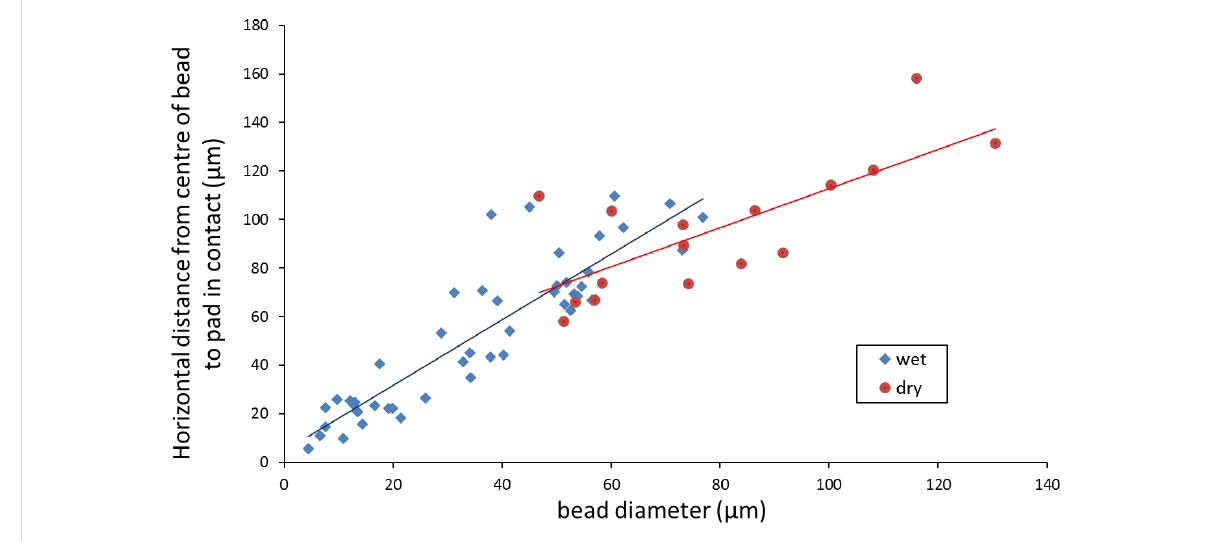
Figure 5: Scatterplot showing correlation between asperity size and pad contact (distance from bead centre to pad in contact with the surface). Data are differently coloured depending on whether fluid completely filled (‘wet’) or only partially filled (‘dry’) the gap created between the pad, bead and surface. In the latter case, the remaining space was filled by an air bubble.